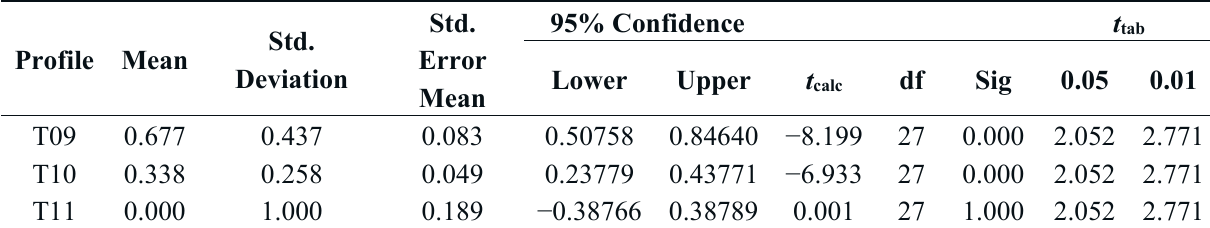
Table 1. Results of paired t tests—Surveys 1 and 22.